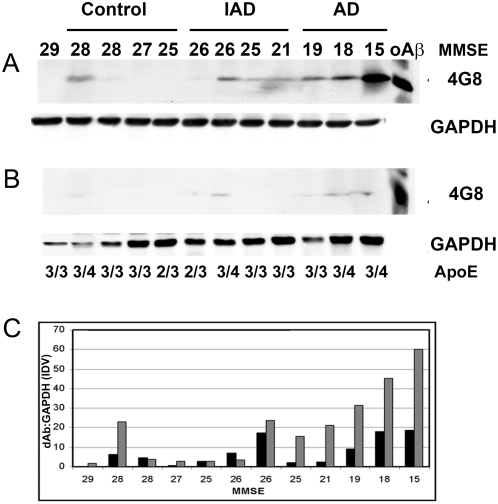
Oligomeric Aβ increases with dementia progression.Oligomeric Aβ dimer (dAβ) is detected with antibody 4G8 on immunoblots of A) whole homogenate or B) synaptoneurosomes prepared from patients with a range of MMSE scores (29-15). A band observed at <10 kD with a migration identical to dAβ, is detectable in IAD patients with MMSE scores of about 26 or less. In C) densitometry reveals that, when normalized to GAPDH, dAβ levels are inversely related to MMSE although patients with an ApoE4 allele (including one control) exhibit higher concentrations of dAβ than patients with comparable MMSE scores but no E4 allele. Homogenate (grey bar) and synaptoneurosome (white bar) samples show increasing dAβ in IAD as the disease progresses. Data are representative of 3 separate experiments. The ratio of dAβ to GAPDH is given in arbitrary units based on the integrated density value which is the sum of all pixel values after background correction (IDV).